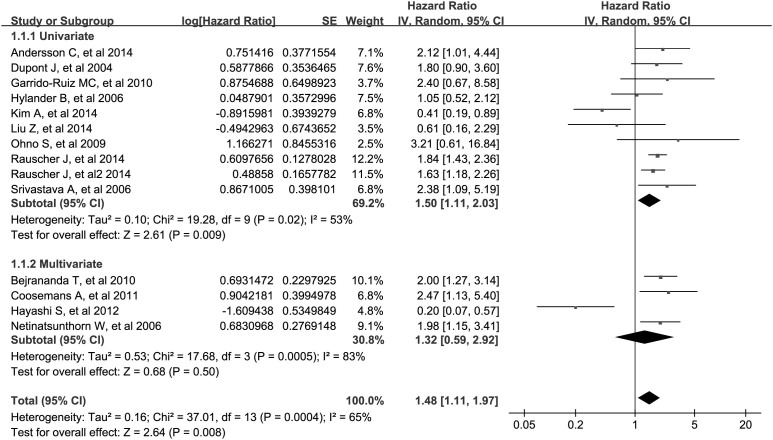
Meta-analysis of impact of WT1 expression on overall survival of patients with solid tumors.Results are presented as individual and metaHR, and 95% CI.